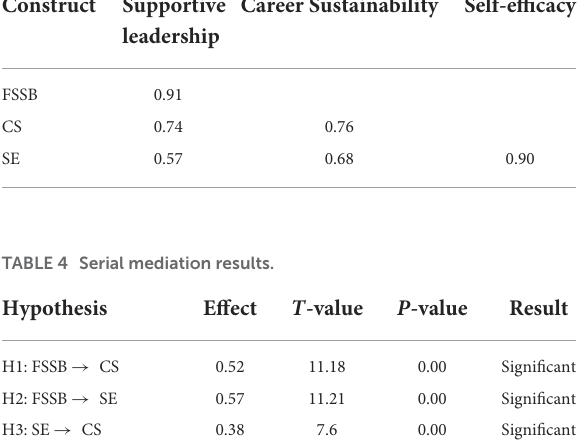
TABLE 3 Analysis of discriminant validity (Fornell-Larcker Criterion).